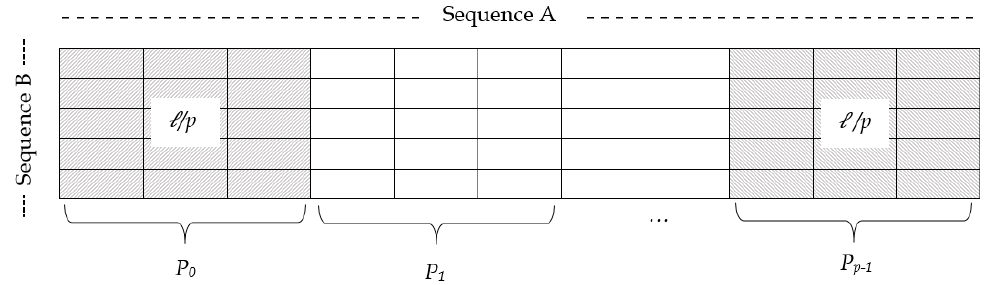
Figure 6. Mapping of a sequence having length (cid:96) to p processing nodes.